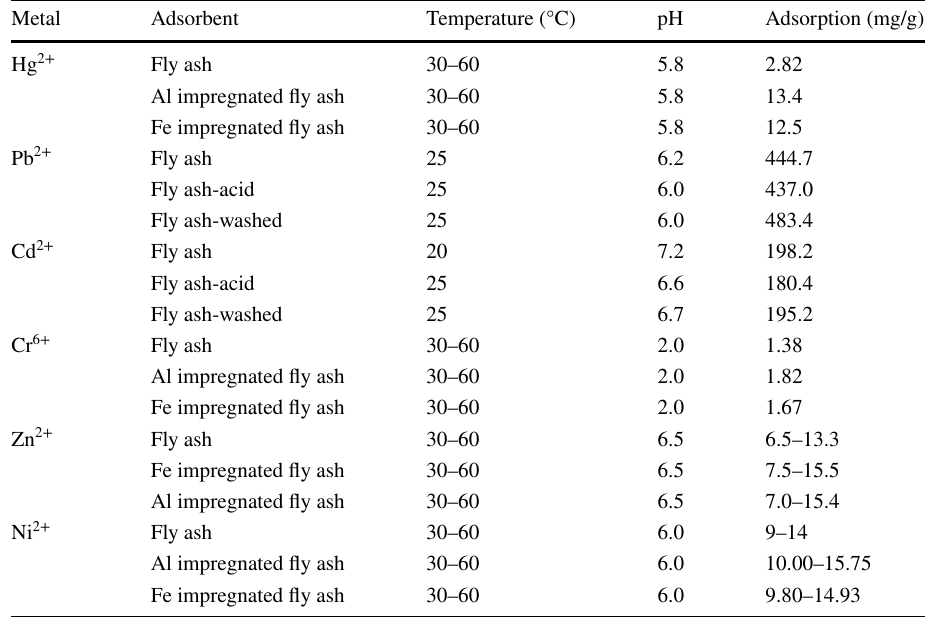
Table 7 Metal ion adsorption on fly ash (Wang and Wu 2006)